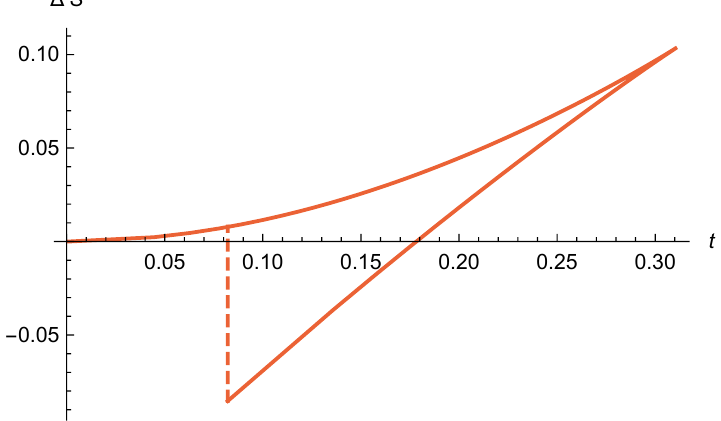
Figure 10 . For d = 4 and λ GB = − 7 / 36 which violates the bound (4.23), the time evolution of extremal surface ‘area’ stops at a finite time t ≈ 0 . 311 . Note that we always select the smaller ‘area’ for entanglement entropy, when one time corresponds to two extremal ‘areas’ in the red polyline. As a result, there is a zeroth-order phase transition of entanglement entropy at t ≈ 0 . 082 .